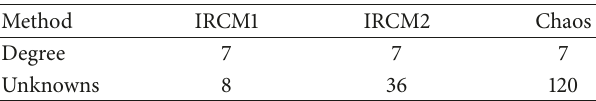
Table 3: Number of coefficients to compute for IRCM1-IRCM2 and PC at degree 7 for the considered number of